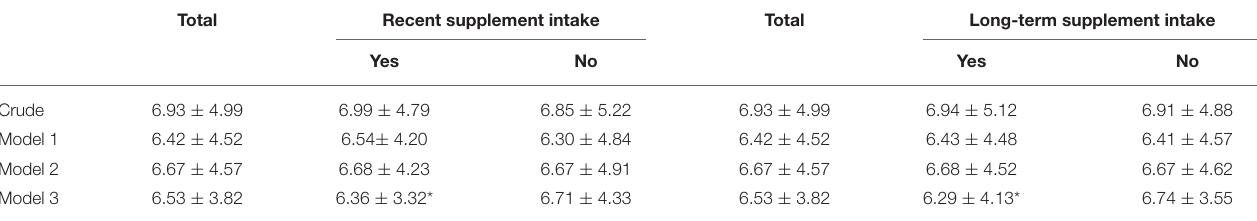
TABLE 5 | Length of hospitalization in different supplement intake categories. Total Recent supplement intake Total Long-term supplement intake